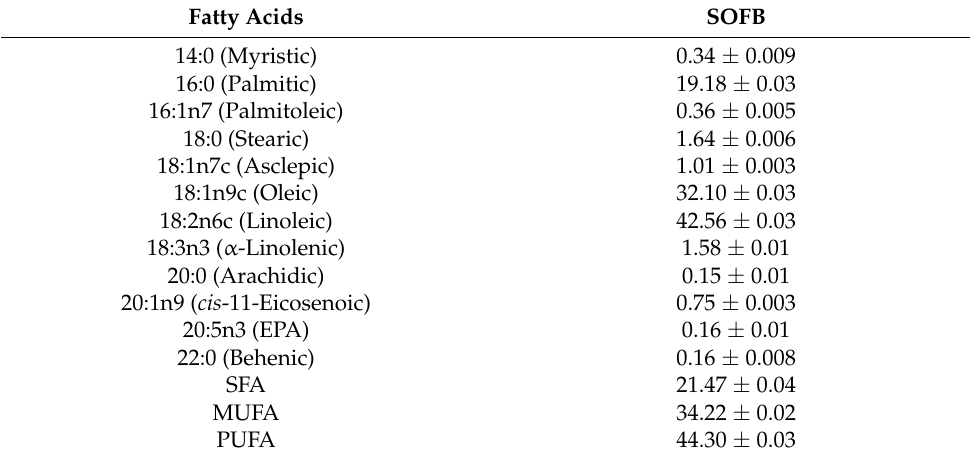
Table 4. Fatty acid profile (g/100 g total fatty acids) of SOFB.